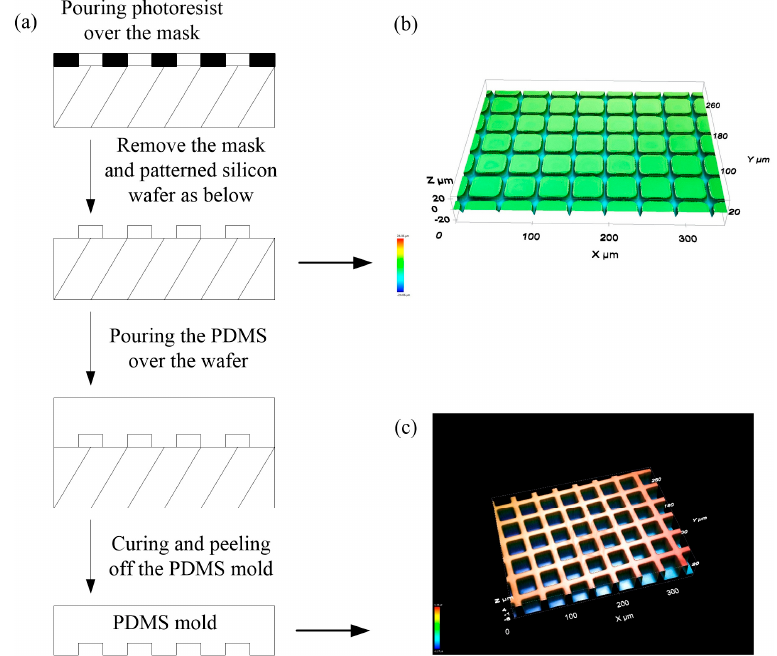
Figure 2. PDMS mold for soft lithograph: ( a ) A schematic illustration of the PDMS mold manufacturing process; ( b ) A patterned silicon wafer with a 10 µ m high square pattern; ( c ) A PDMS mold made using the patterned silicon wafer shown in b.